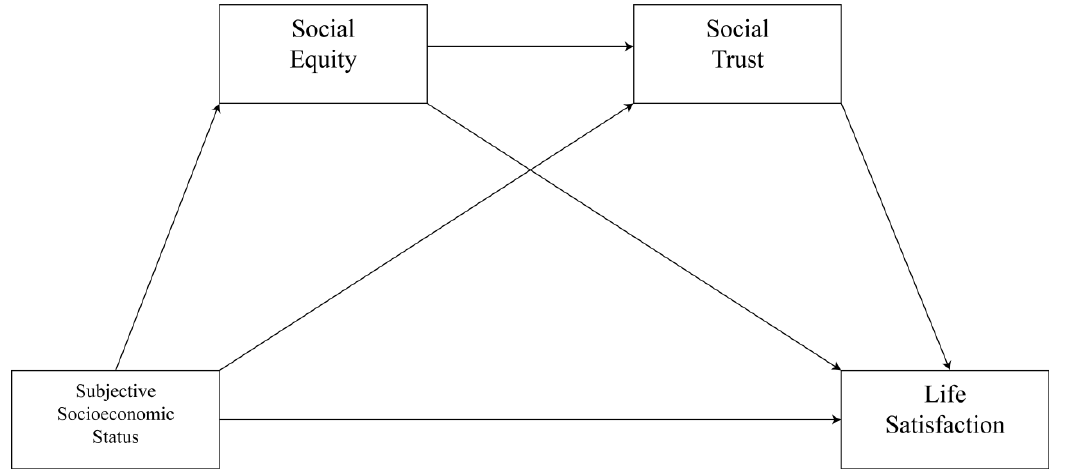
Figure 1. The multiple mediation